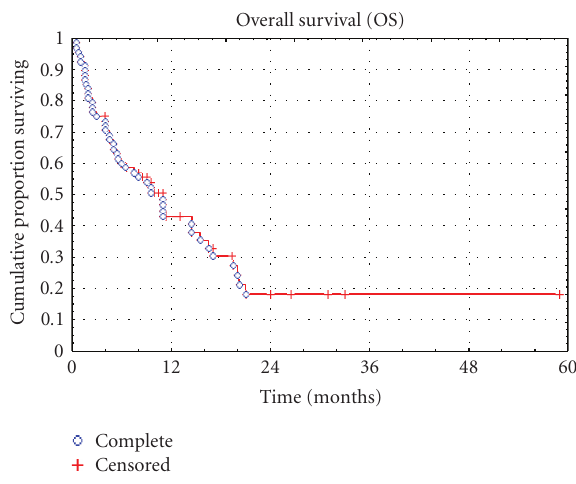
Figure 4: Kaplan-Meier Curve of overall survival for the STS sub-